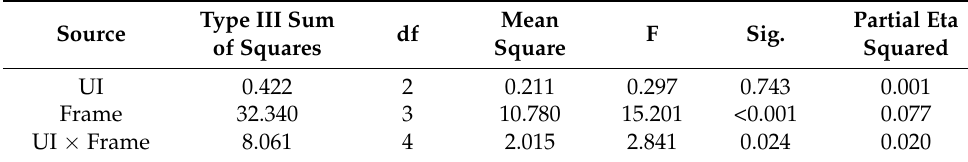
Table 7. Tests of between-subjects effects. Dependent Variable: